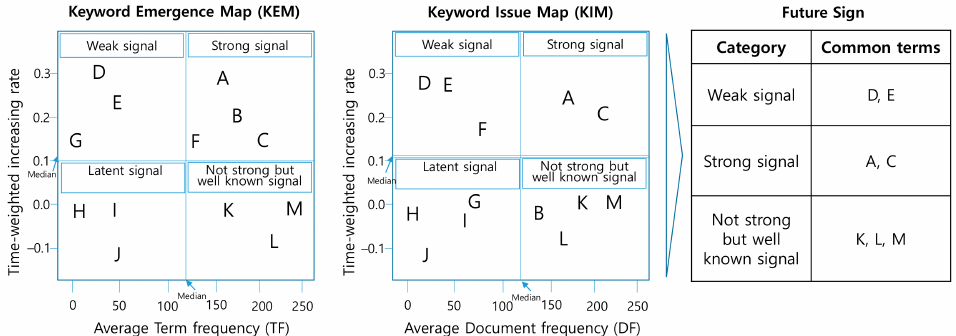
Figure 1. Existing process identifying future signs by using text mining